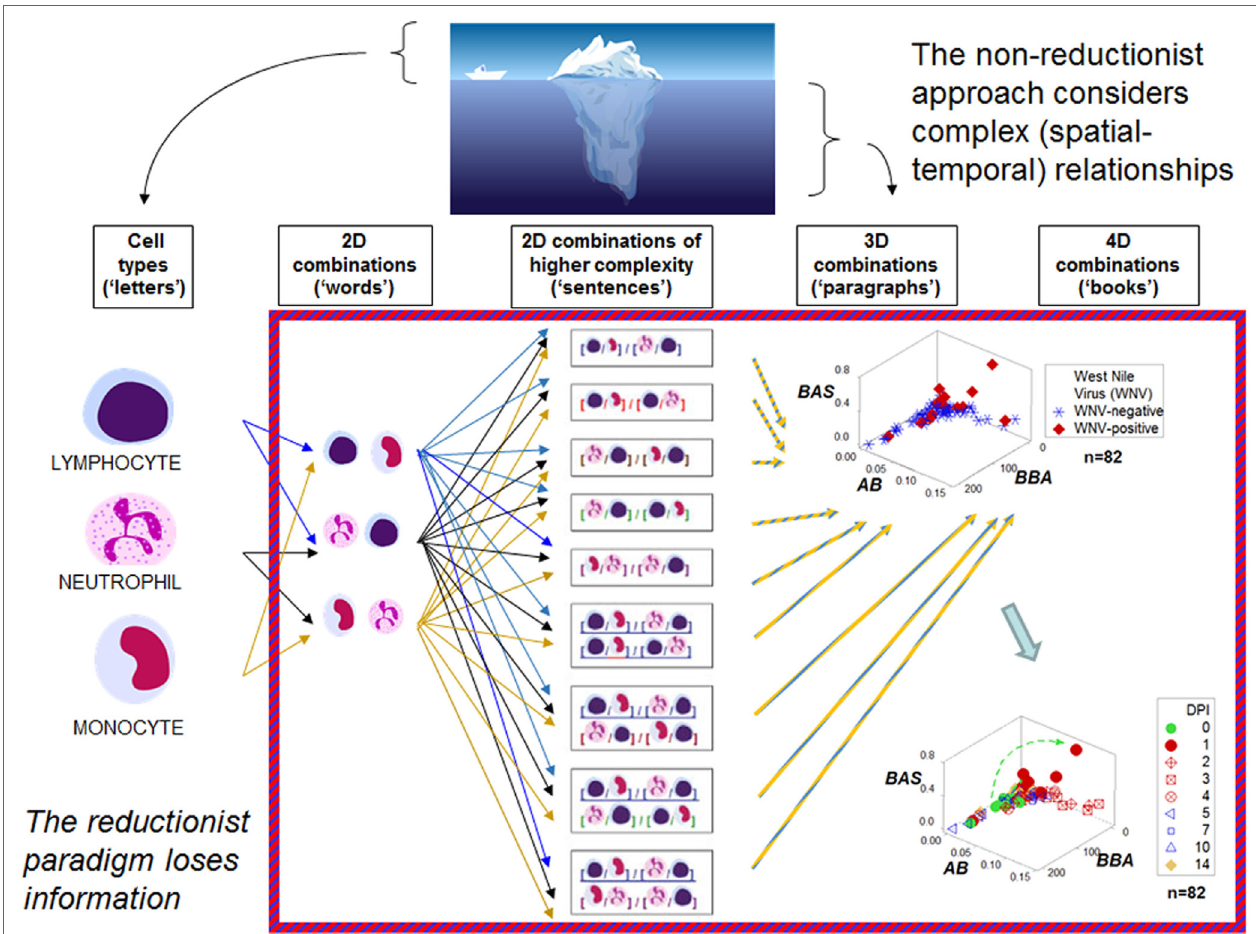
FiGURe 1 | Reductionist and non-reductionist views . An iceberg is used to describe (i) reductionism (the “tip of the iceberg”, i.e., an easily measured entity that does not express all the available information), and (ii) non-reductionism (a combinatorial and spatial–temporal analysis of biological complexity and dynamics, i.e., the area “below the surface”). These concepts are illustrated with an analogy that refers to written language. While simple elements (“letters”) lack meaning, combinations of increasing complexity (“words”, “sentences”, “paragraphs”, “books”) exhibit distinct patterns that facilitate the partitioning of the data into subsets. The hypothetical indicators measured in the three-dimensional (3D)/four-dimensional (4D) plots shown on the right side in the figure—a set taken from the large group of dimensionless indicators shown in the central column—are identified with descriptors that lack any known biological meaning: “ BAS ”, “ AB ”, and “ BBA .” One example of a dimensionless indicator is the result from calculating: [M/L * N/M]/[N/L * L/M] over [M + L/N] * [L + N/M]/[N + M]/L * [M/N]. DPI: day(s) postinoculation with West Nile virus. Data source: Ref.